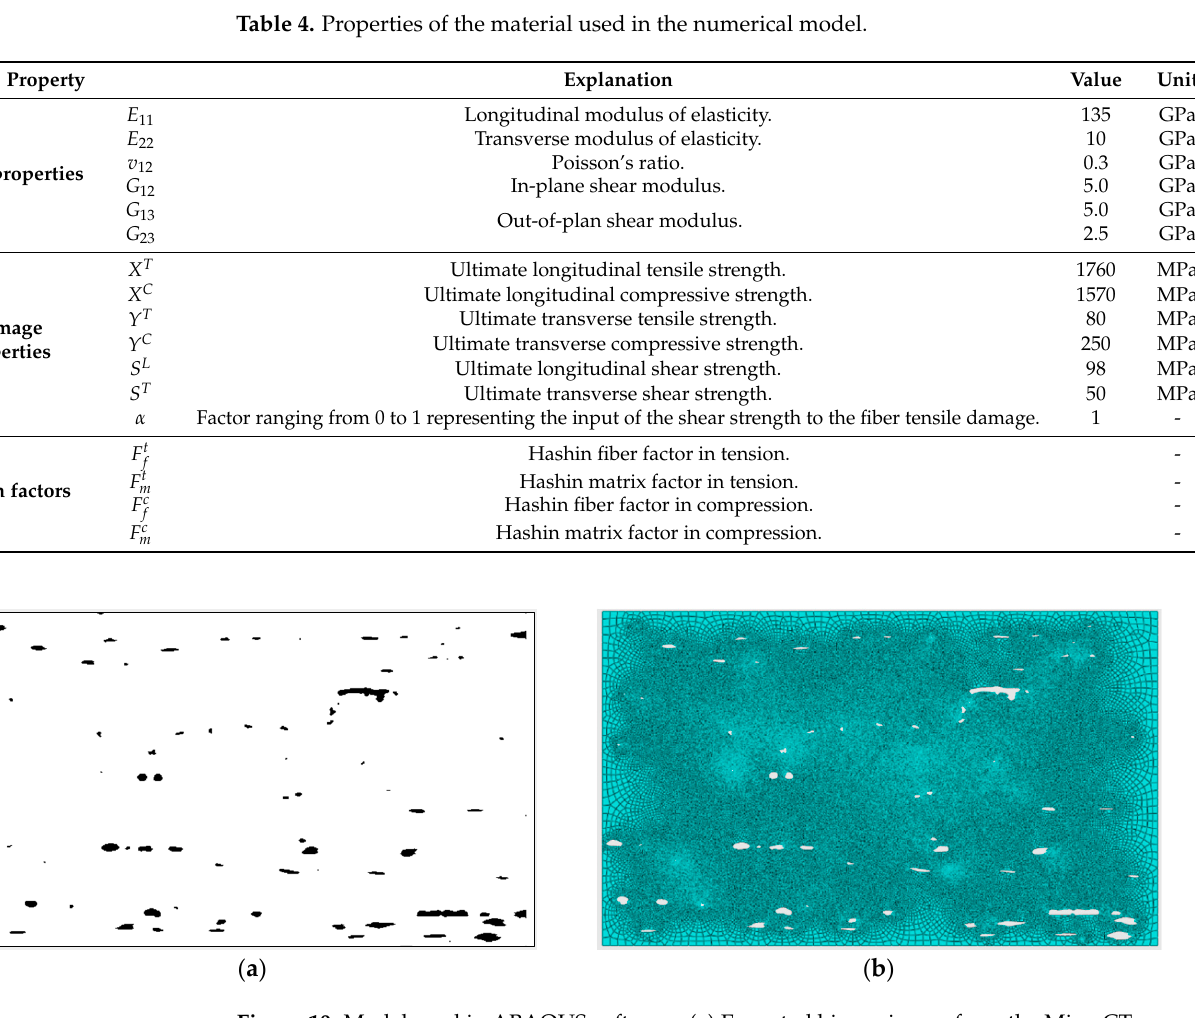
Figure 10. Model used in ABAQUS software; ( a ) Exported binary image from the MicroCT scan, ( b ) The meshed created model. Table 4. Properties of the material used in the numerical model.